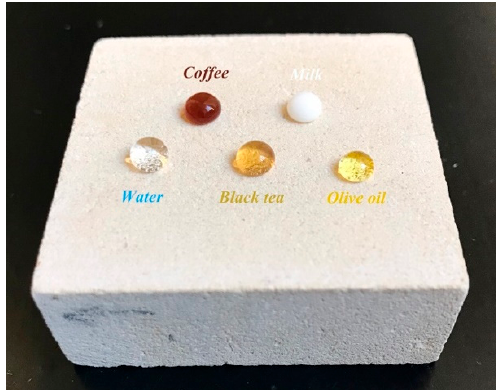
Figure 8. The superamphiphobicity of the as-prepared surface.